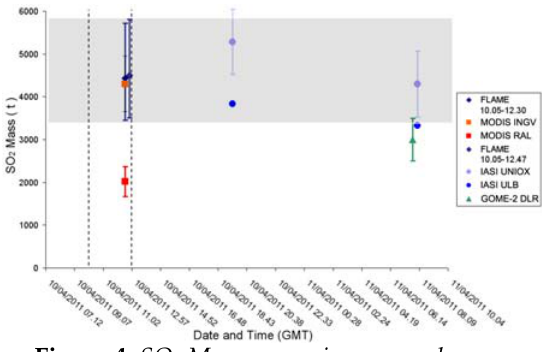
Figure 4: SO 2 Mass comparison ground vs satellite measurements across Mt. Etna for the 10 April 2011 paroxysmal event.